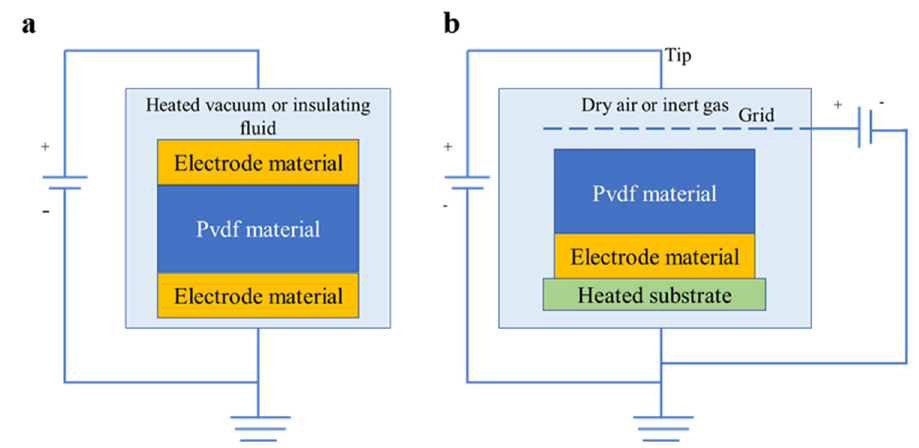
Figure 6. ( a ) Schematic of electrode poling method; and ( b ) corona poling method.